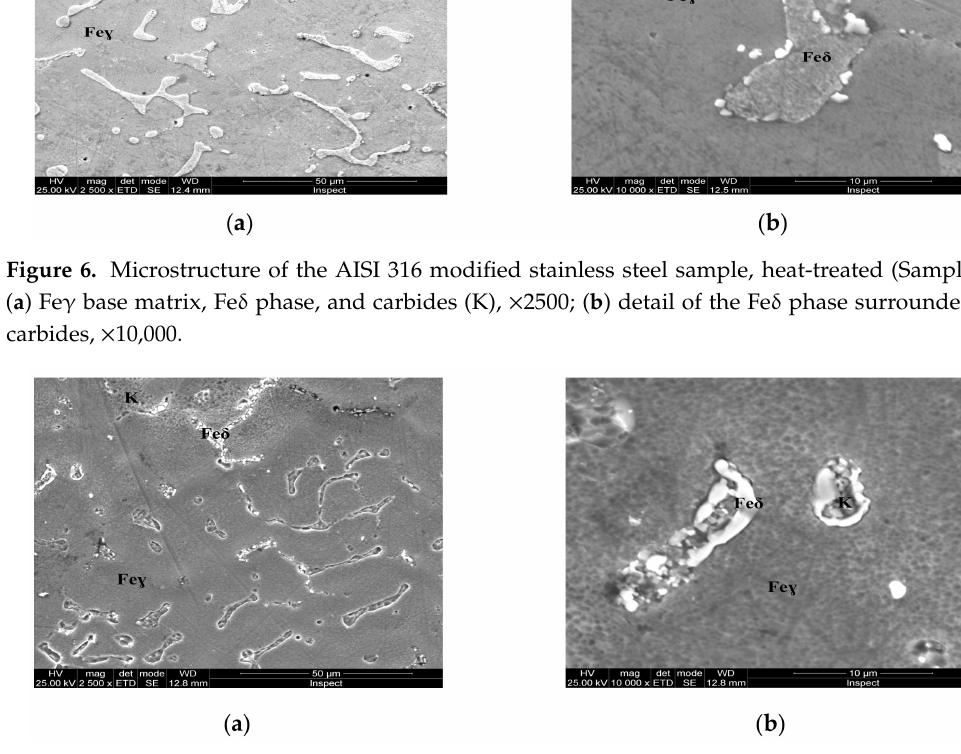
Figure 7. Microstructure of the AISI 316 modified stainless steel sample, heat-treated (Sample C): ( a ) Fe γ base matrix, Fe δ phase and carbides (K) × 2500; ( b ) detail of the Fe δ phase surrounded by larger carbides, ×